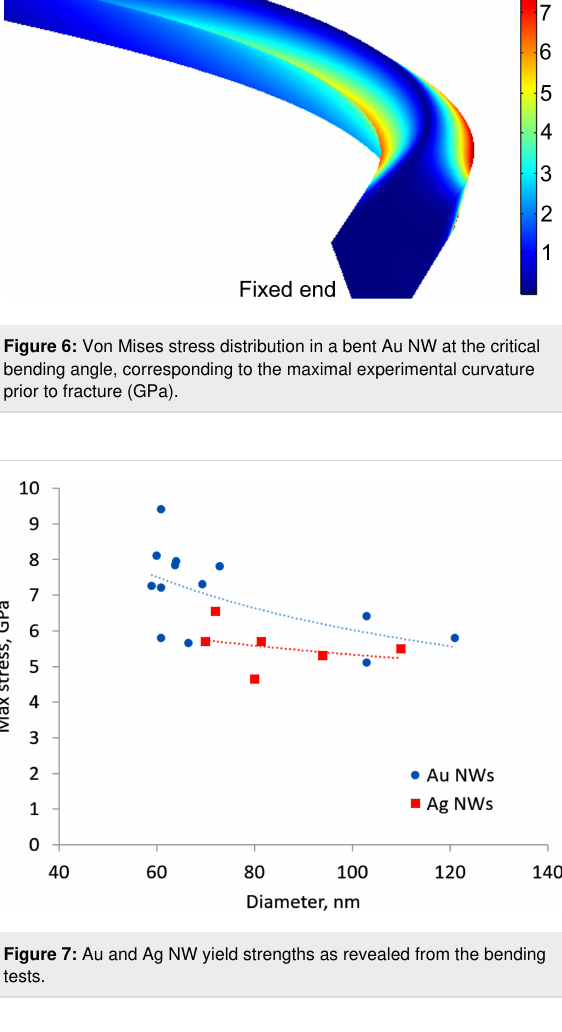
that measurements in [28] were performed in dynamic mode, that is, the probe and hence the NW were oscillating during the measurements with amplitude on the order of 100 nm. More- over, the experiments were performed in a lower resolution SEM. Therefore, if an abrupt transition took place, it was left unnoticed. However, the sudden slope change on the force–dis- placement curve in Figure 5 in [28] can be explained by the sudden transition from elastic-to-plastic